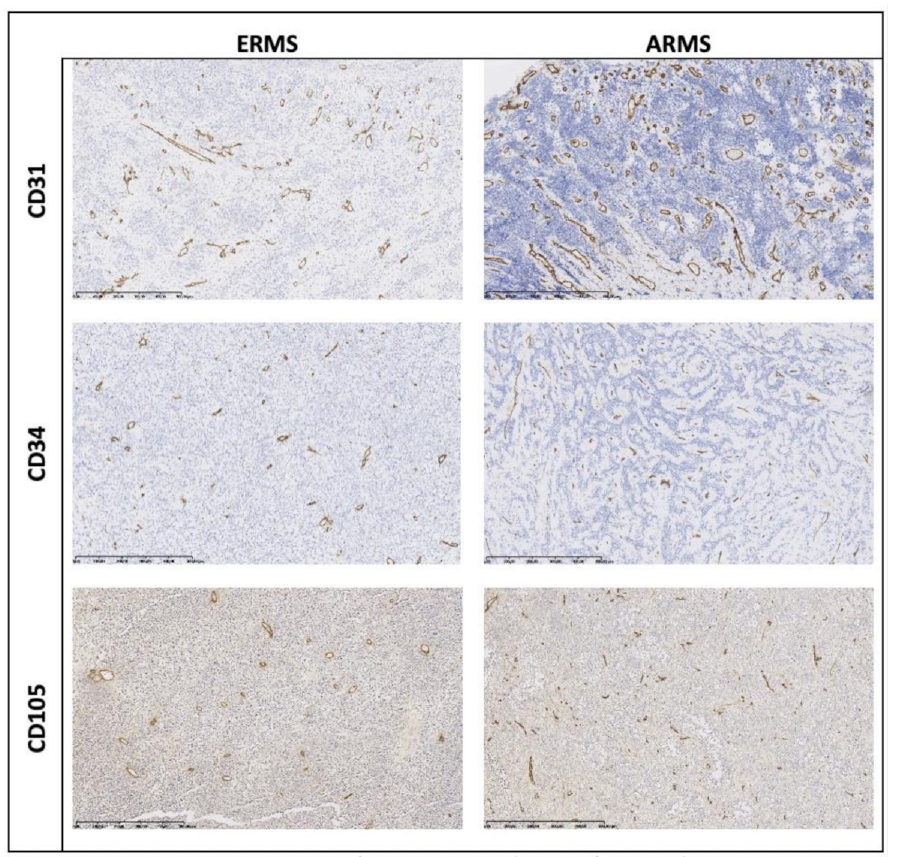
Figure 2. Representative immunostaining for CD31, CD34, and CD105 of ERMS and ARMS. Magnifi- cation: 100 × .